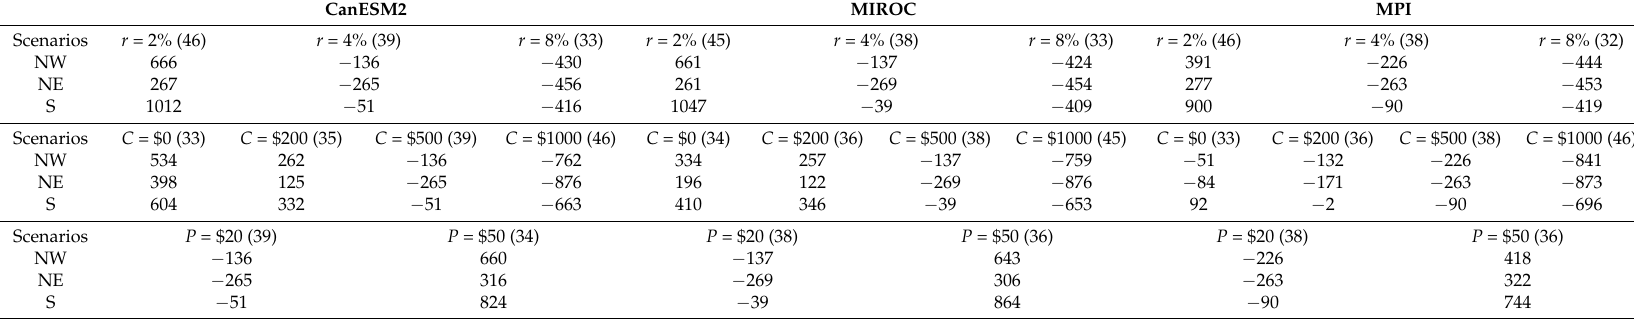
Table 3. Sensitivity analyses of wood-only scenario, showing variation in NPV ($ · ha − 1 ) with varying discount rate ( r ), establishment cost ( C ), and stumpage value ( P ). CanESM2 MIROC MPI